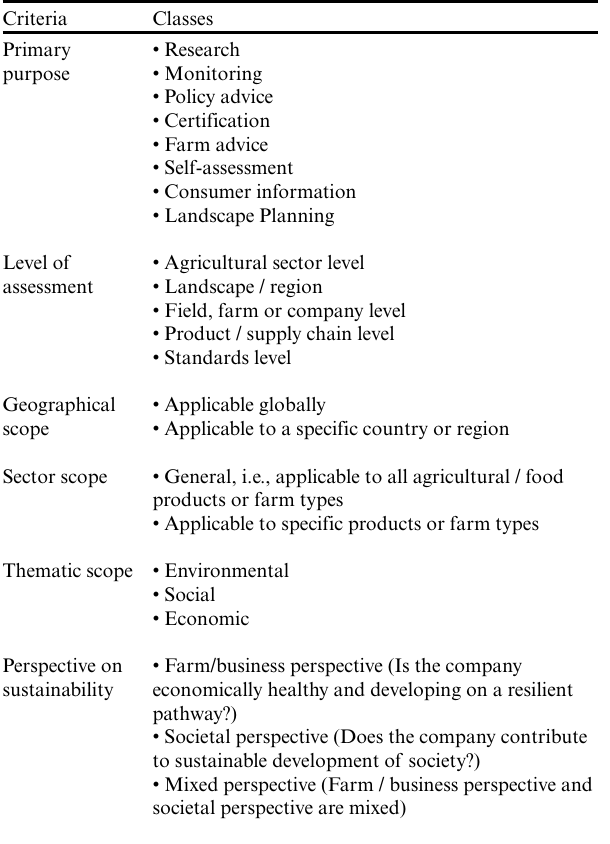
Table 1 . Typology for characterizing and comparing the scope of the sustainability assessment